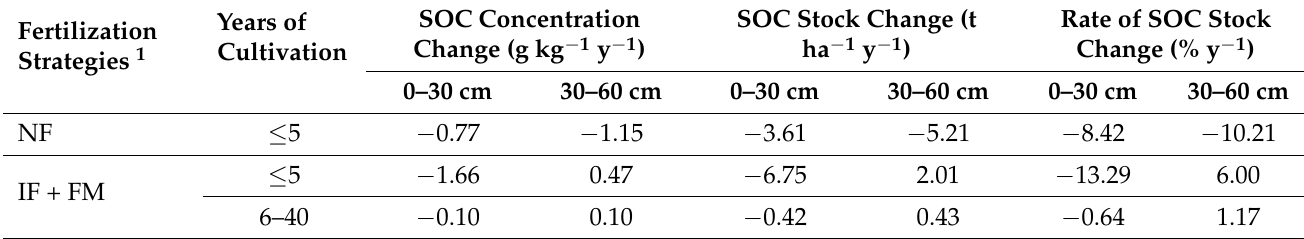
Table 6. Soil organic carbon change in vineyards between the establishment and 2015.